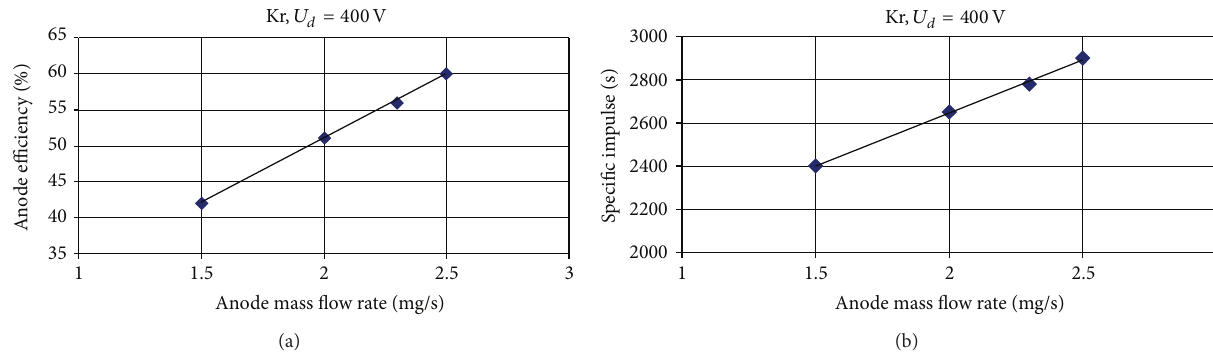
Figure 6: ATON A-3 (a) anode efficiency and (b) specific impulse versus Kr anode mass flow rate under 𝑈 𝑑 = 400 V.